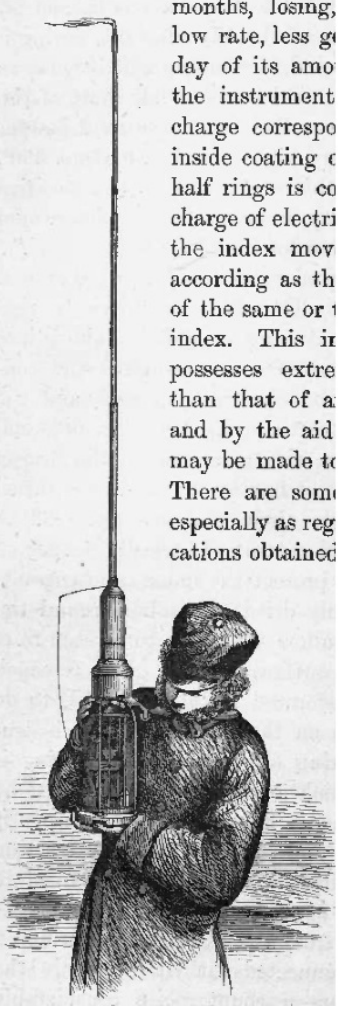
Figure 6 Drawing of a Kelvin portable electrometer, attached to a flame probe and carried by an assistant. Figure 6. Drawing of a Kelvin portable electrometer, attached to Note the rural location, probably Arran. From REM §263. a flame probe and carried by an assistant. Note the rural location, probably Arran. From REM